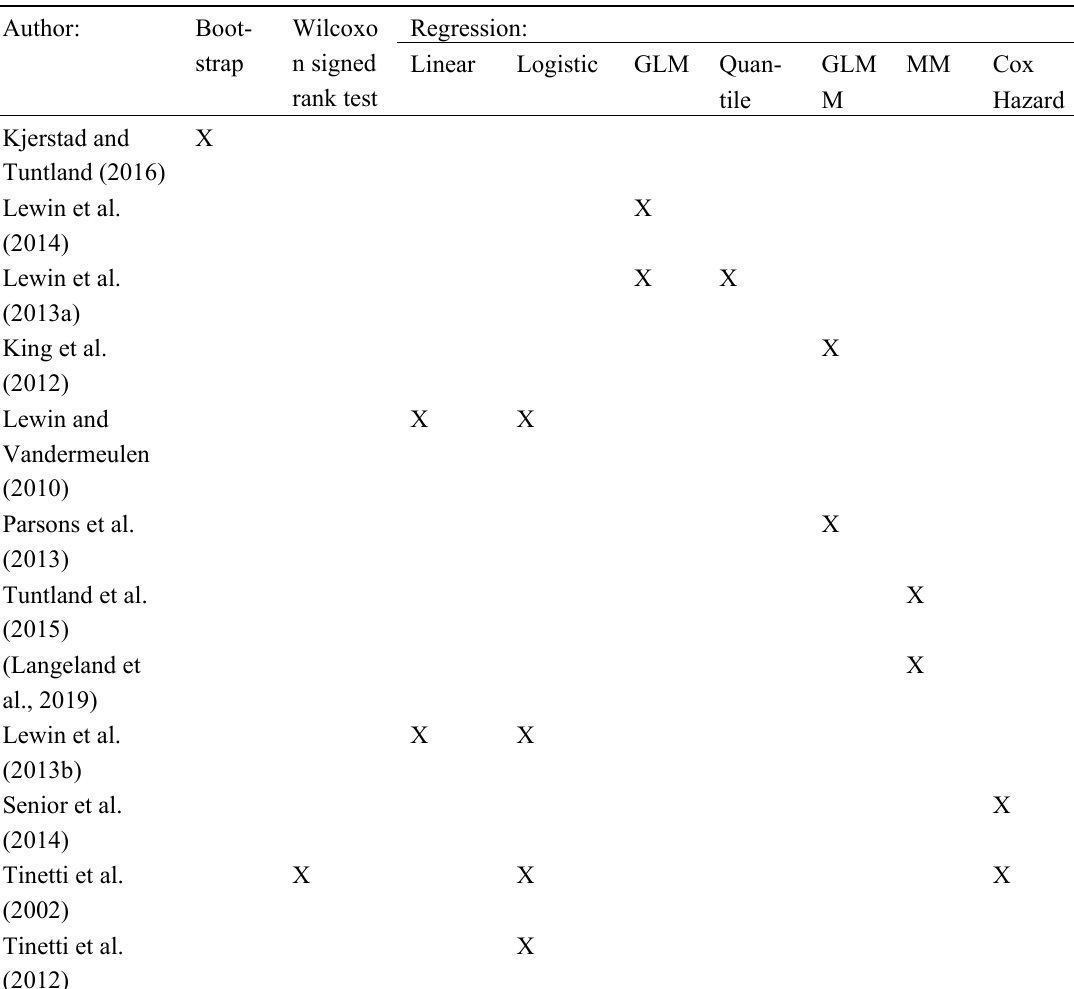
Table 3: Statistical methods for primary outcome in each